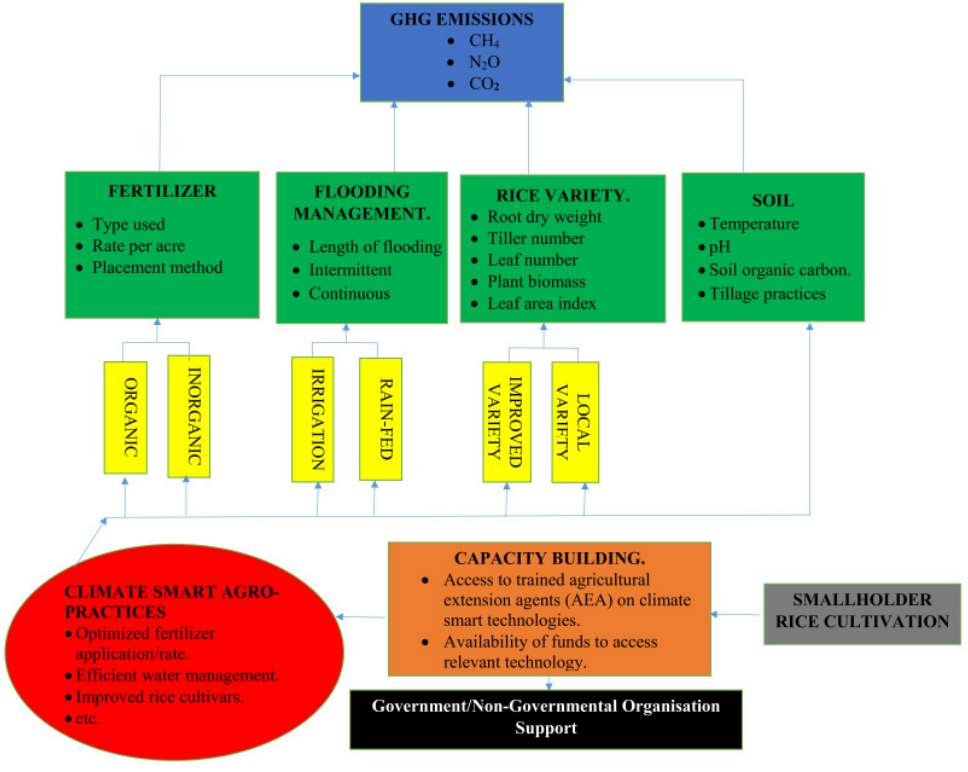
Figure 1. Conceptual framework.